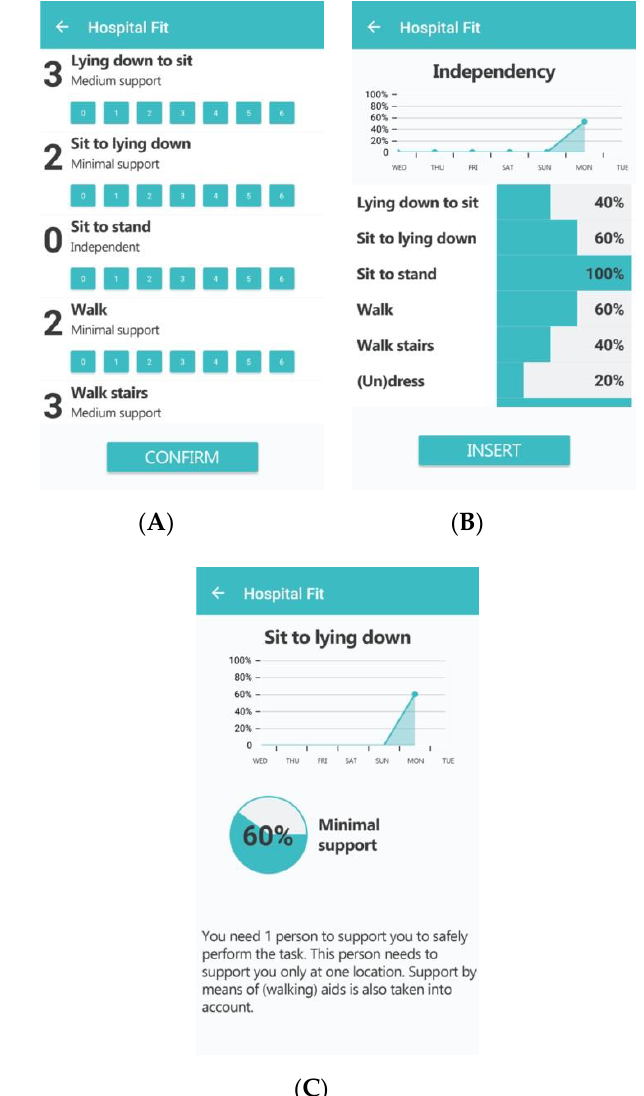
Figure 3. Recovery assessment with the option of scoring the extent of functional recovery based on the modified Iowa Level of Assistance Scale ( A ); an overview of the extent of functional recovery ( B ); the amount of assistance needed and progress over time per activity ( C ).